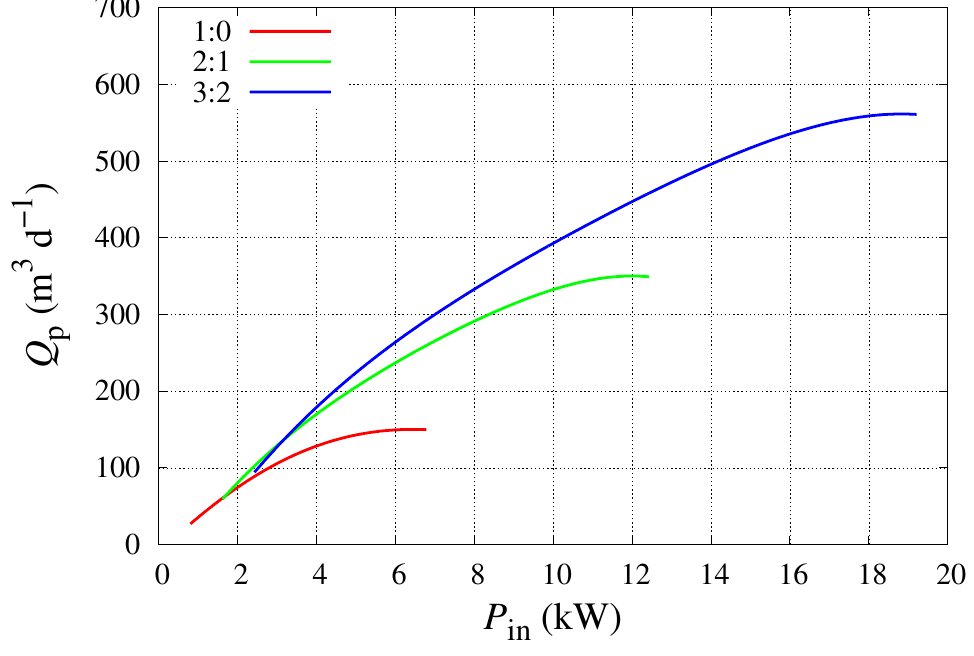
Figure 8. Curves of maximum Q p for different BWRO configurations using sample 11 (Table 1) as C f